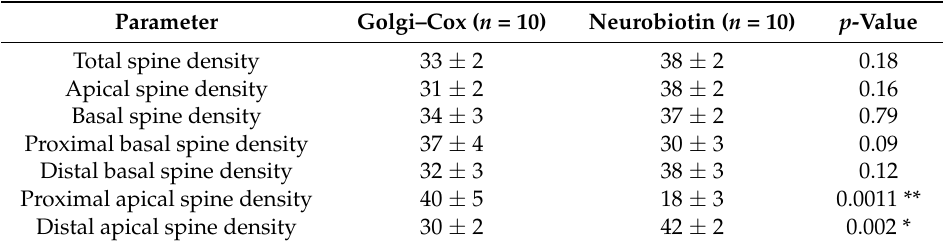
Table 2. Dendritic Spine density (spines per 100 µ m).